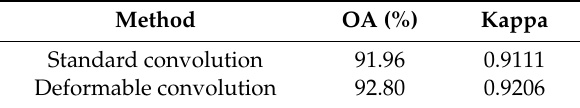
Table 7. Comparison of standard and deformable convolution.